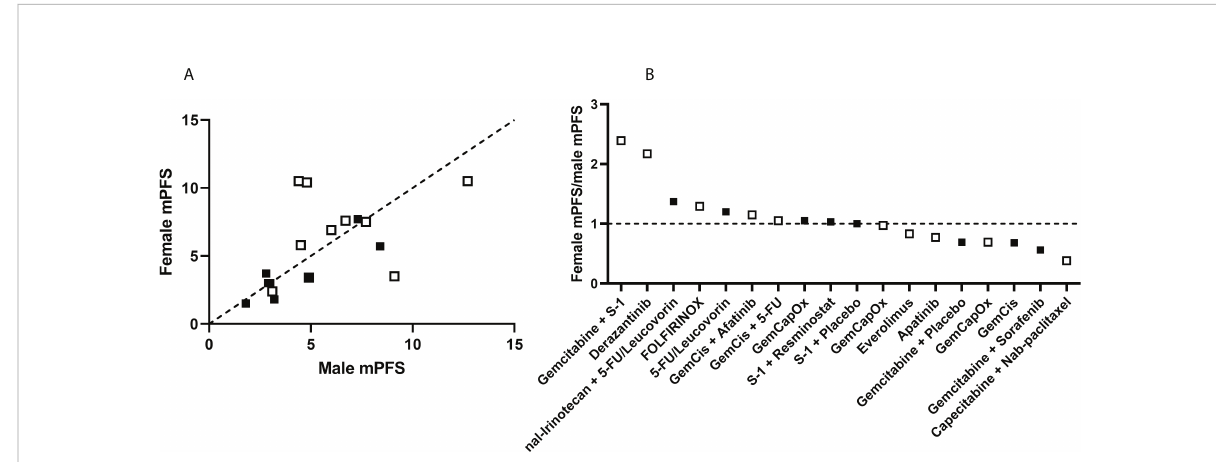
FIGURE 3 Comparison of disease progression in female and male participants in treatment trials of cholangiocarcinoma. (A) Data were obtained from participants in 19 treatment groups from 15 studies. Treatment groups above the dotted line of equivalence have a higher median progression free survival (mPFS) in females compared with males. (B) The ratio of mPFS in females to mPFS in male is plotted for each treatment group. Treatments with higher mPFS in females are plotted above the dotted line, with ratio >1. Randomized of treatment was performed in studies represented by solid dots, non-randomized studies as open